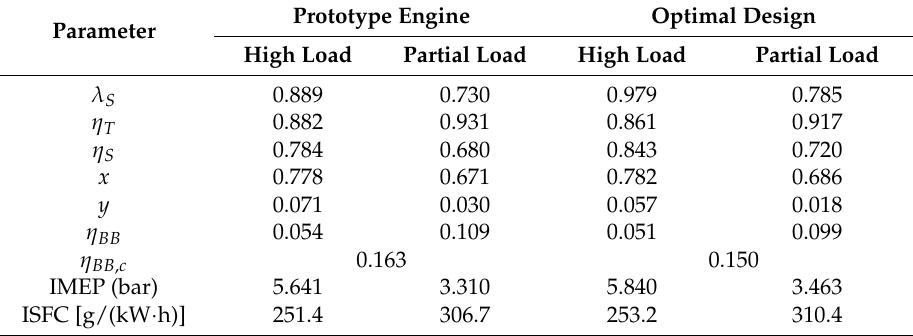
Table 9. Apart from the scavenging parameters and evaluation objective functions discussed before, the conventional power performance and fuel economy indicators, IMEP and ISFC, are taken into consideration as well. Because mechanical loss (pumping loss, throttling loss, friction loss, etc.) is not involved in AVL FIRE simulation, indicated indexes are analyzed rather than effective indexes. Table 9. Comparison results between the prototype engine and optimal